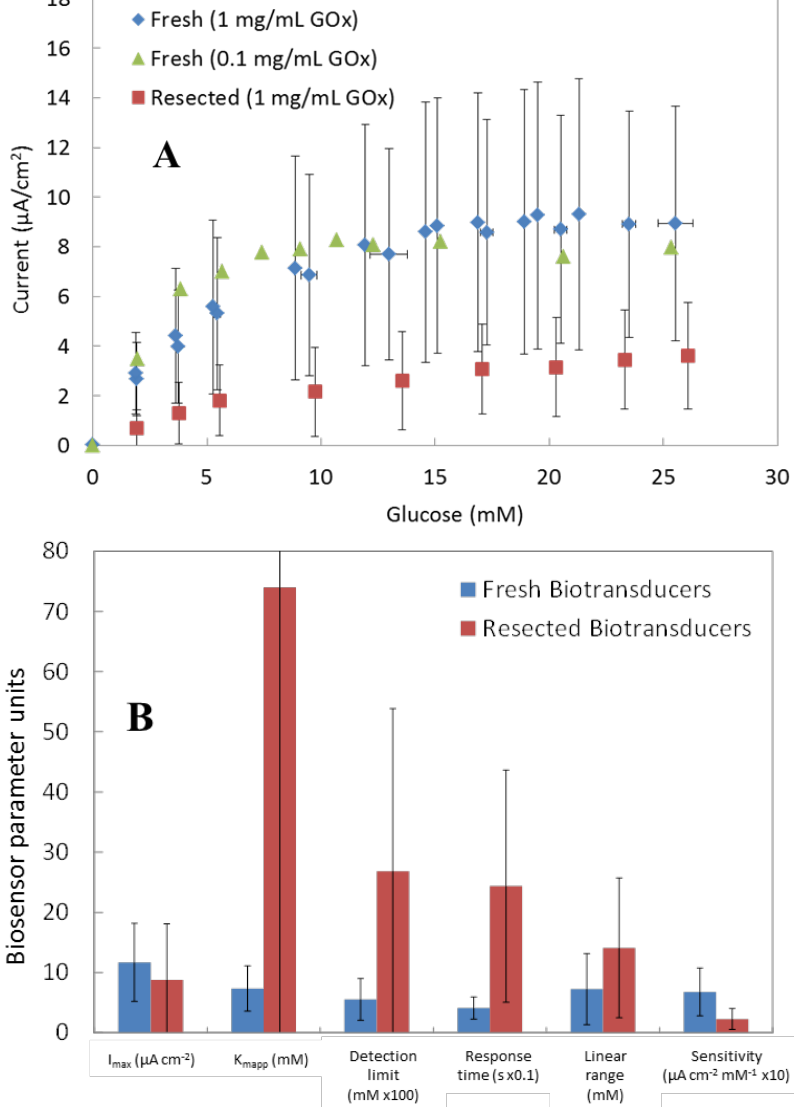
Figure 7. ( A ) Dose response of MDEA 5037-Pt biotransducers to glucose with enzyme concentration used for fabrication shown in parentheses, and ( B ) Bioanalytical performance of glucose biosensors after being freshly fabricated and following resection from